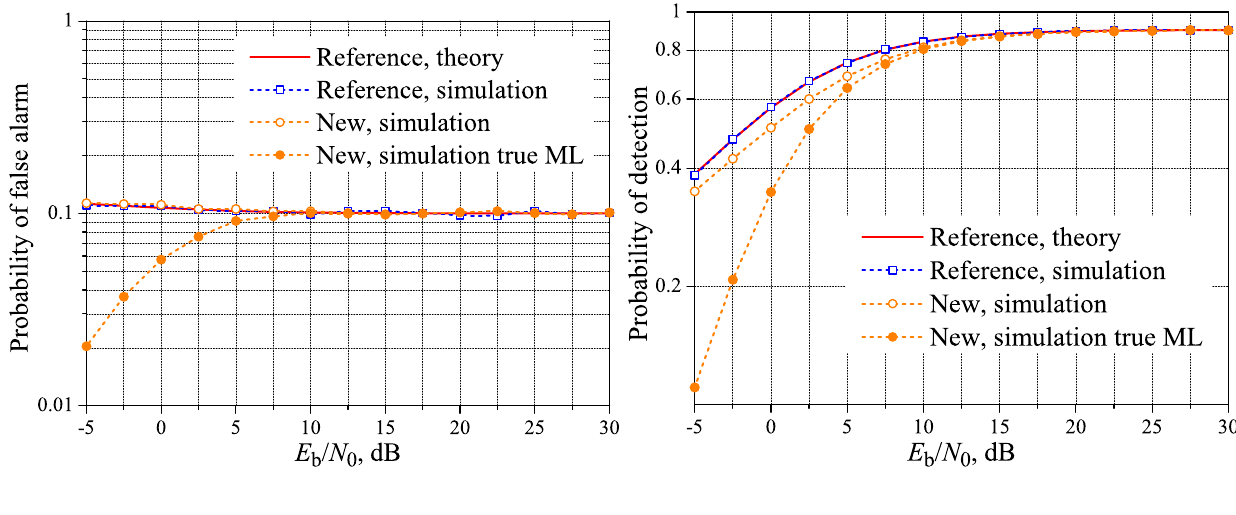
Figure 9. Spectrum sensing performance for the complex-valued Rayleigh reporting channel. M = 3 and K = 1 ( top ); K = 2 ( middle ); and K = 3 ( bottom ).